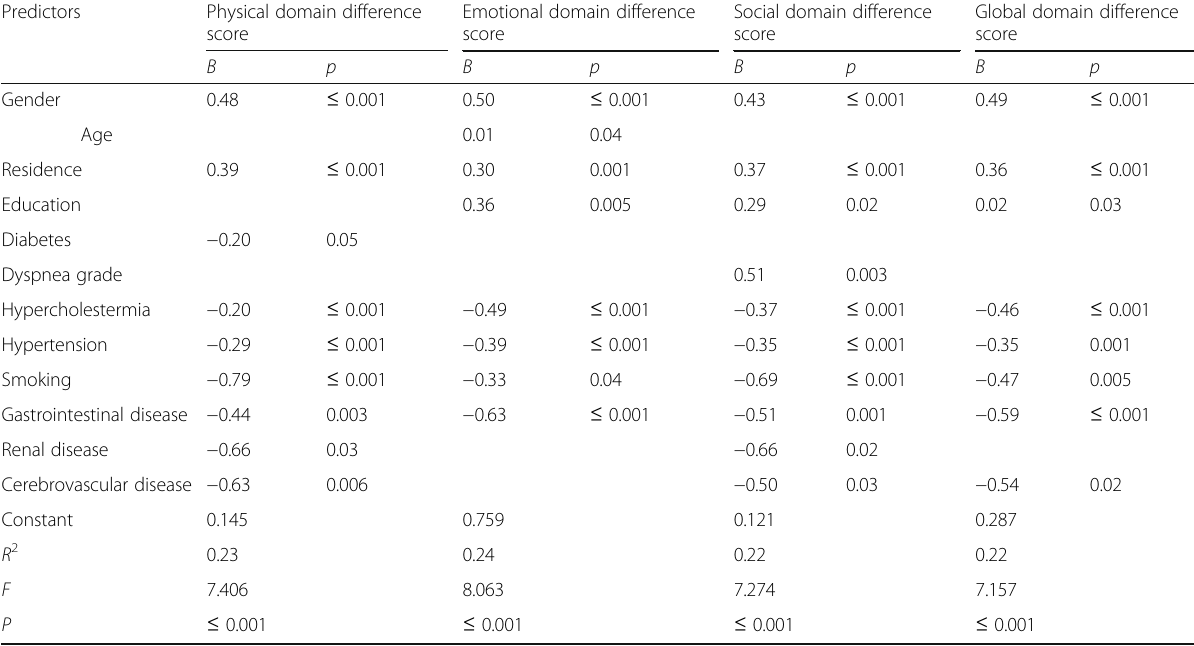
Table 2 Multiple linear regression analysis of independent predictors of physical, emotional, social, and global QOL-normalized difference score after 3 months of CABG surgery